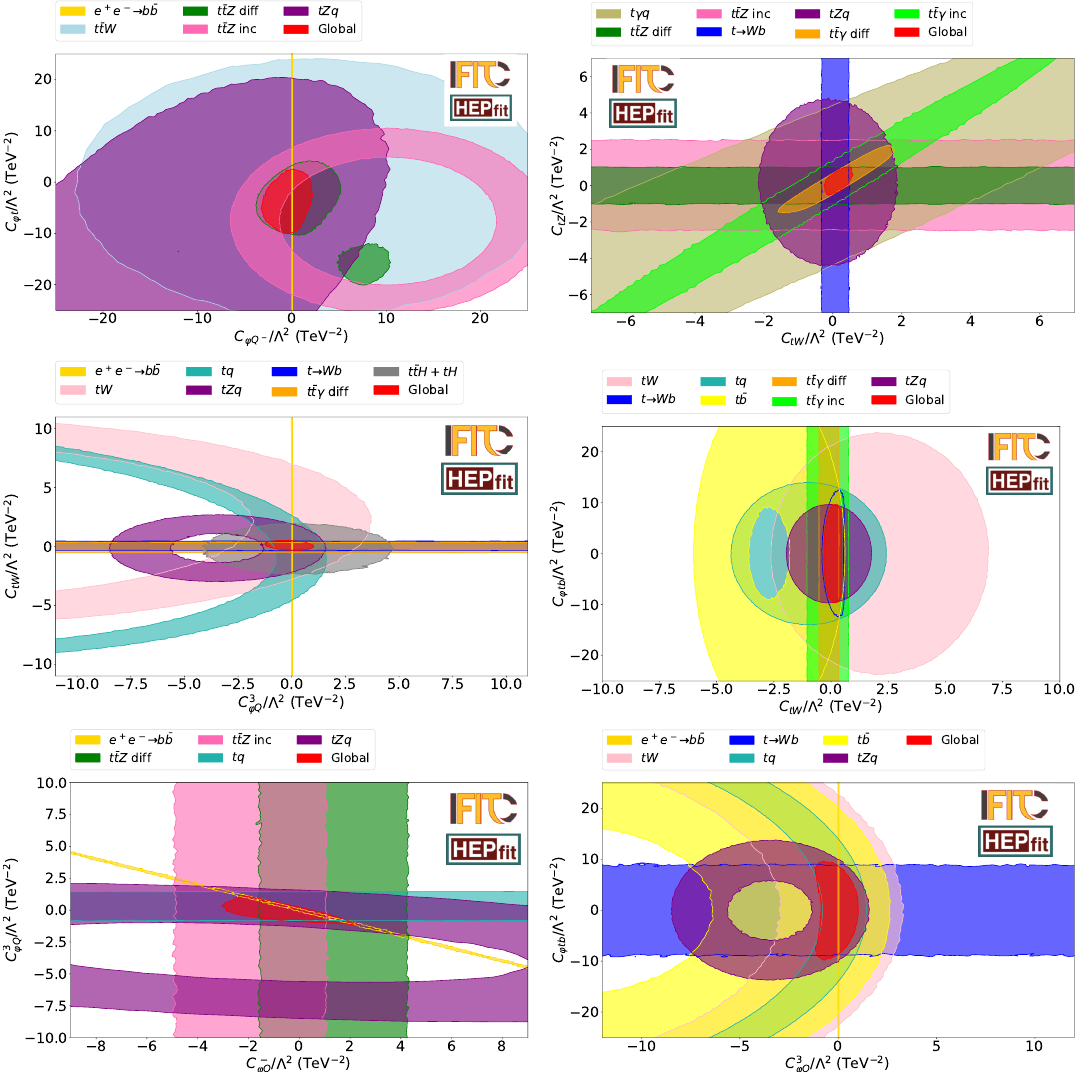
Figure 3 . Two-dimensional 95% probability bounds on pairs of Wilson coefficients, C − and C ϕt in ϕQ the upper leftmost panel, C tW and C tZ in the upper rightmost panel, C 3 and C tW in the middle ϕQ leftmost panel, C tW and C ϕtb in the middle rightmost panel, C 3 and C − in the lower leftmost ϕQ ϕQ panel, and C ϕtb and C 3 in the lower rightmost panel. Bounds are presented for two-parameter fits ϕQ to the most constraining measurements. The global fit results, marginalising over all other Wilson coefficients, are also shown (red area). All these fits include Λ − 4 terms. Besides QCD production, in the case of t ¯ tW process, the contribution of the electro-weak t ¯ tWq production is also included.